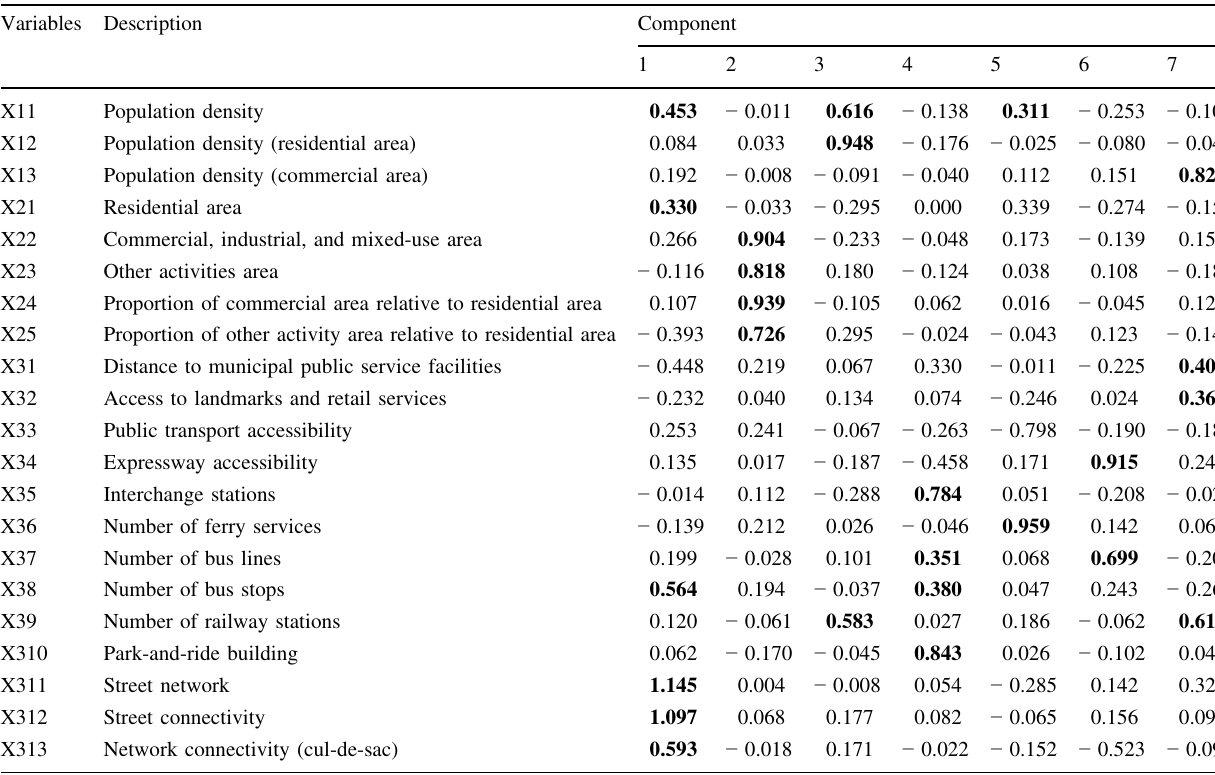
Table 6 Pattern matrix Variables